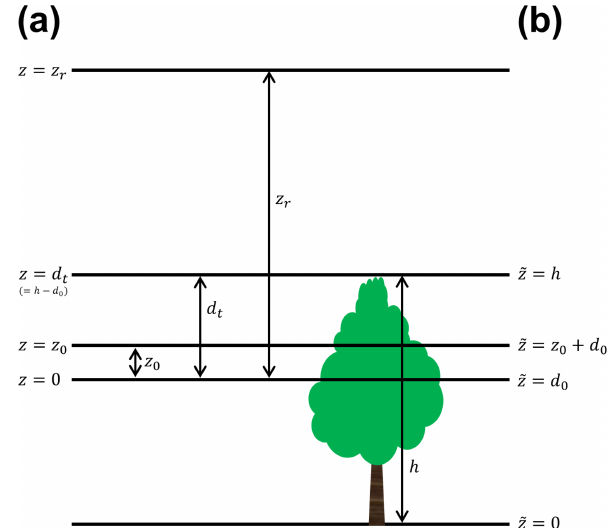
Figure 1. The schematic diagram to describe the vertical coordi- nate systems used in this study. (a) The vertical coordinate of the Yonsei University surface layer (YSL) schemes ( z ) is defined as the distance from the conventional zero-plane displacement height ( d 0 ) and (b) the convectional coordinate ( ˜ z ) is defined as the distance from terrain surface. Here, z 0 , d t , h , and z r are roughness length, the redefined zero-plane displacement height in Harman and Finni- gan (2007), canopy height, and the lowest model layer in the con- ventional coordinate,